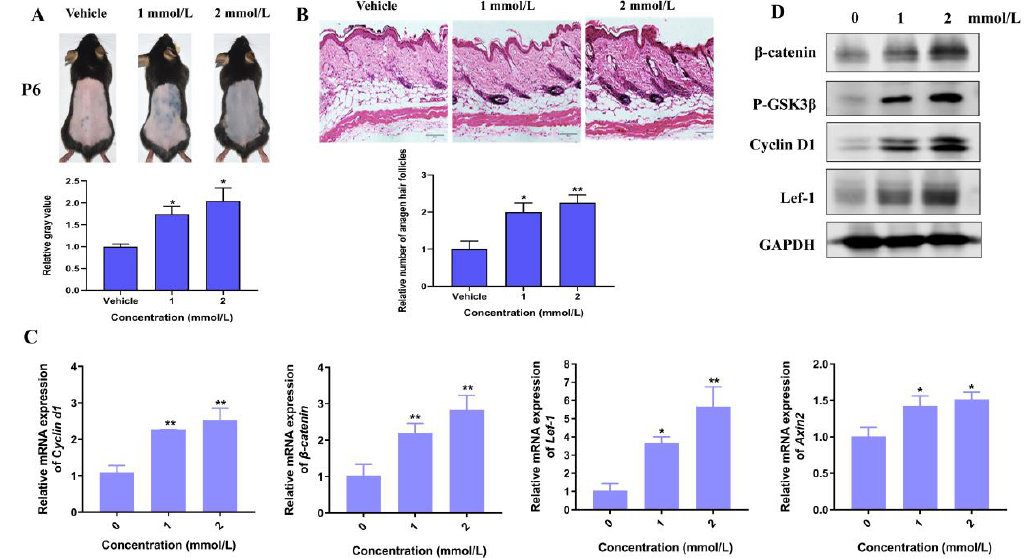
Figure 4. Hordenine increases the activity of Wnt/ β -catenin signaling pathway in depilatory mice. ( A ) Representative photos of the mouse dorsal hairs in day 6 after Hordenine treatments. The bar chart showing the grey values of skin color. ( B ) Hematoxylin and eosin staining (HE) of the mouse dorsal skin hair follicles after Hordenine treatments in day 6 (Magnification, × 200; bars = 50 µ m). The bar graph showing the average number of hair follicles in skin tissues. ( C ) The mRNA expression of β -catenin , Lef-1 , Cyclin d1 and Axin2 were examined by RT-qPCR in mouse dorsal skin. ( D ) Western blot analysis of β -catenin, p-GSK-3 β , Lef1, CyclinD1 in mouse dorsal skin. Data are expressed as means ± SD. * p < 0.05, ** p < 0.01, Hordenine versus control.